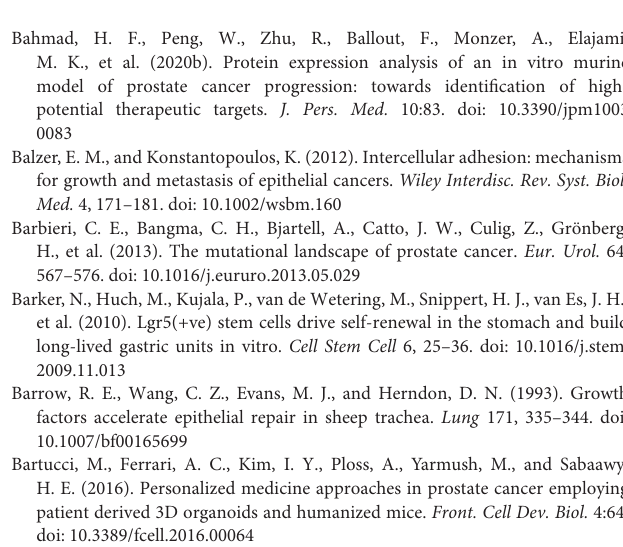
Supplementary Figure 4 | Gene set enrichment analysis (GSEA) of the top 20 signaling pathways activated in AUB-PrC cells relative to their tissue counterparts among the unaffected samples. Comparison of data sets indicated unaffected AUB-PrC cells had enrichment of cell cycle pathways, E2F signaling, TP53 Supplementary Figure 5 | Gene set enrichment analysis (GSEA) of the top 20 signaling pathways activated in AUB-PrC cells relative to their tissue counterparts among the tumor samples. Comparison of data sets indicated tumor AUB-PrC cells had enrichment of cell cycle pathways, PLK1 signaling, DNA irradiation Supplementary Table 1 | Patients’ clinical characteristics. Supplementary Table 2 | Overview of specific components and their respective concentrations added to prepare human prostate organoids culture medium. Adopted and modified from Drost et al. (2016). Supplementary Table 3 | Primer sequences and annealing temperatures for select human genes. Supplementary Table 4 | Gene set database used for pathway enrichment analysis (Human_GOBP_AllPathways_no_GO_iea_April_01_2020_symbol.gmt; downloaded from http://baderlab.org/GeneSets). Supplementary Table 5 | List of all differentially expressed genes (DEGs) between AUB-PrC cells and their tissue counterparts in unaffected samples.